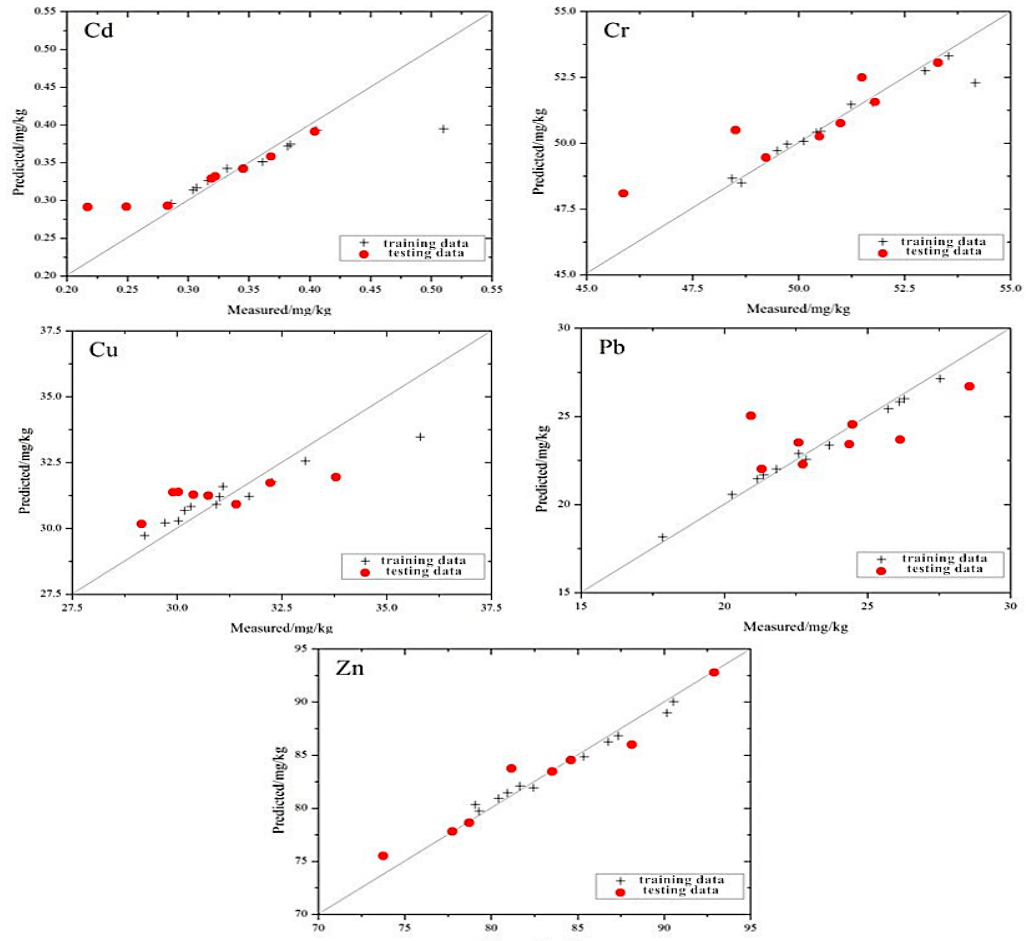
Figure 7. Individual points of heavy metal concentrations in the mine reclamation soils predicted by the SMO-SVM model plotted against the measured values.